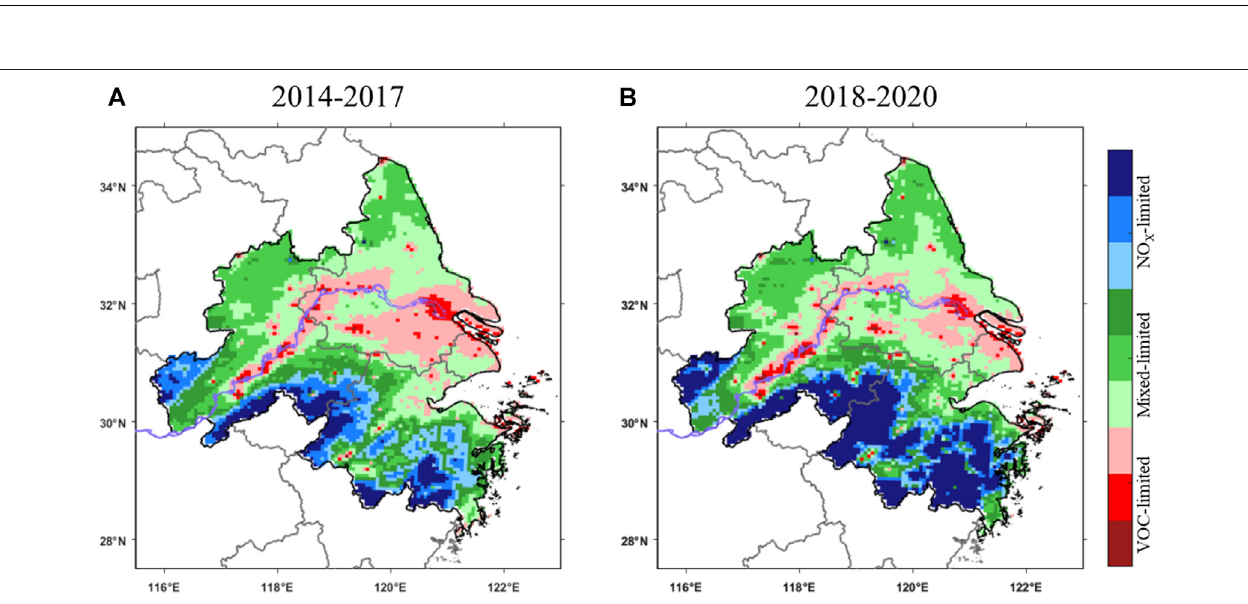
FIGURE 4 | Spatial distribution of the indicator (HCHO/NO y ) for diagnosing the O 3 formation regime over the YRD region in the summertime. (A) indicates 2014 – 2017, and (B) indicates 2018 – 2020. Red, green, and blue shaded areas represent VOC-limited, mix-limited, and NO x -limited condition, respectively.